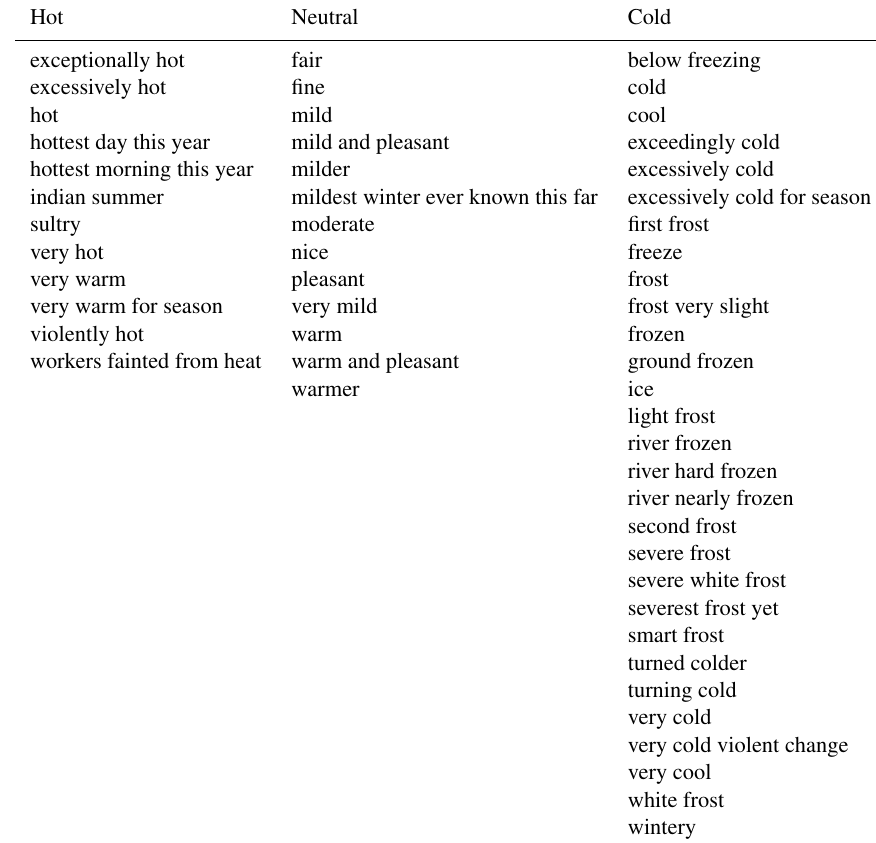
Table 6. Temperature index categories.